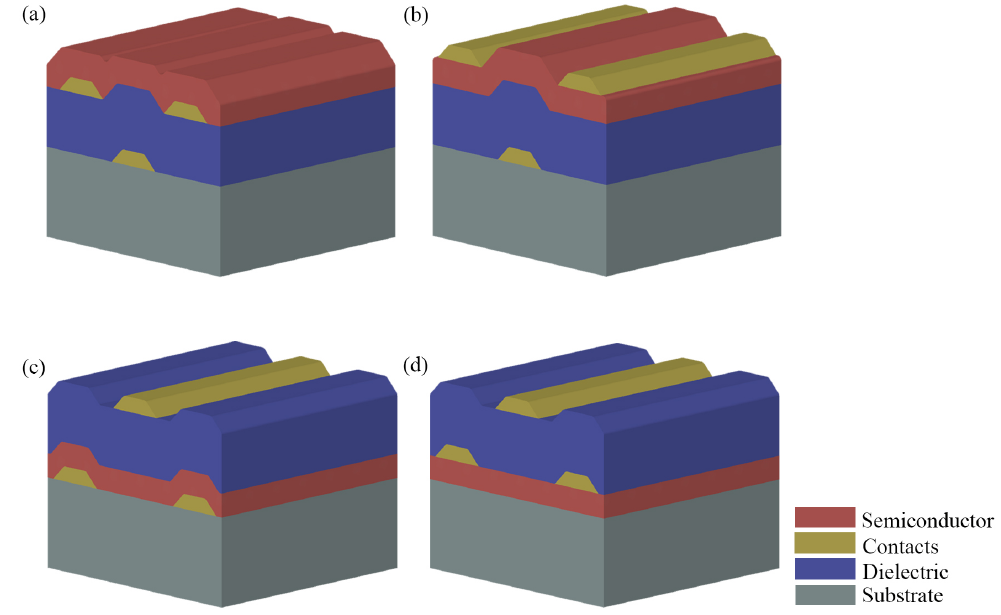
Figure 2. Organic thin-film structures: bottom gate, (inverted) ( a ) bottom contact (coplanar) and ( b ) top contact (staggered); top gate, ( c ) bottom contact and ( d ) top contact. Note that the device is not fully scaled, since the substrate thickness can vary from less than a mi- cron to more than a millimeter. Stacked films are not necessarily flat and conformability depends on the deposition techniques